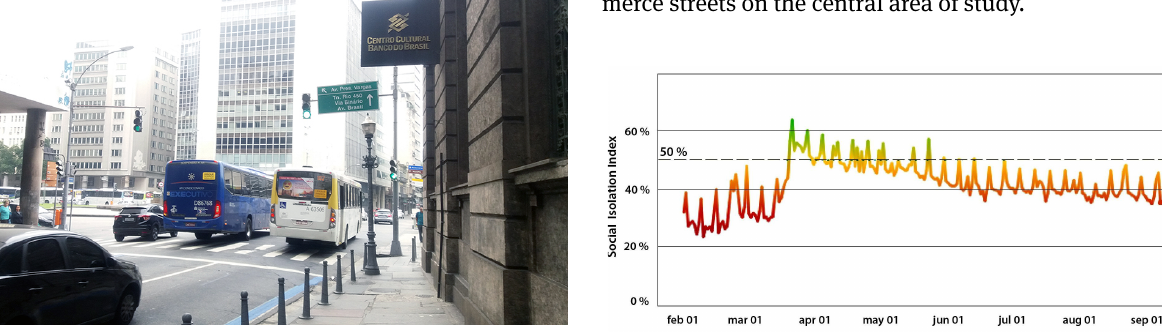
Figure 5: Isolation index for Rio de Janeiro city